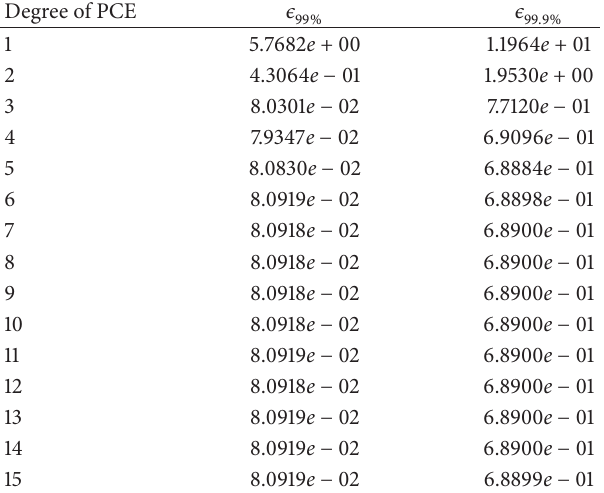
Figure 8: Absolute errors of the two quantiles the PCE approximation of GBM at time 𝑇 = 1 , whose parameters are 𝑟 = 3 %, 𝜎 = 15 %, and starting value 𝑆 0 = 100 . Table 4: Absolute errors of the two quantiles PCE approximation of GBM at time 𝑇 = 1 , whose parameters are 𝑟 = 3 %, 𝜎 = 15 %, and starting value 𝑆 Degree of PCE 𝜖 99 % 𝜖 99.9 %